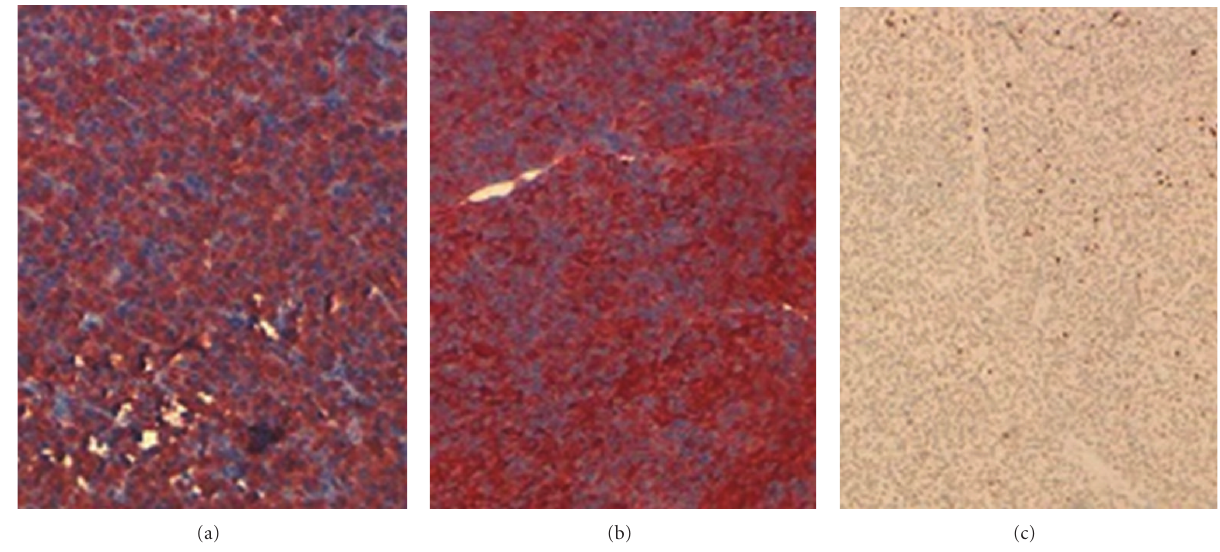
Figure 3: Intense and widespread staining of CD79A (a) and CD 138 (b), Ki 67 very low < 10%